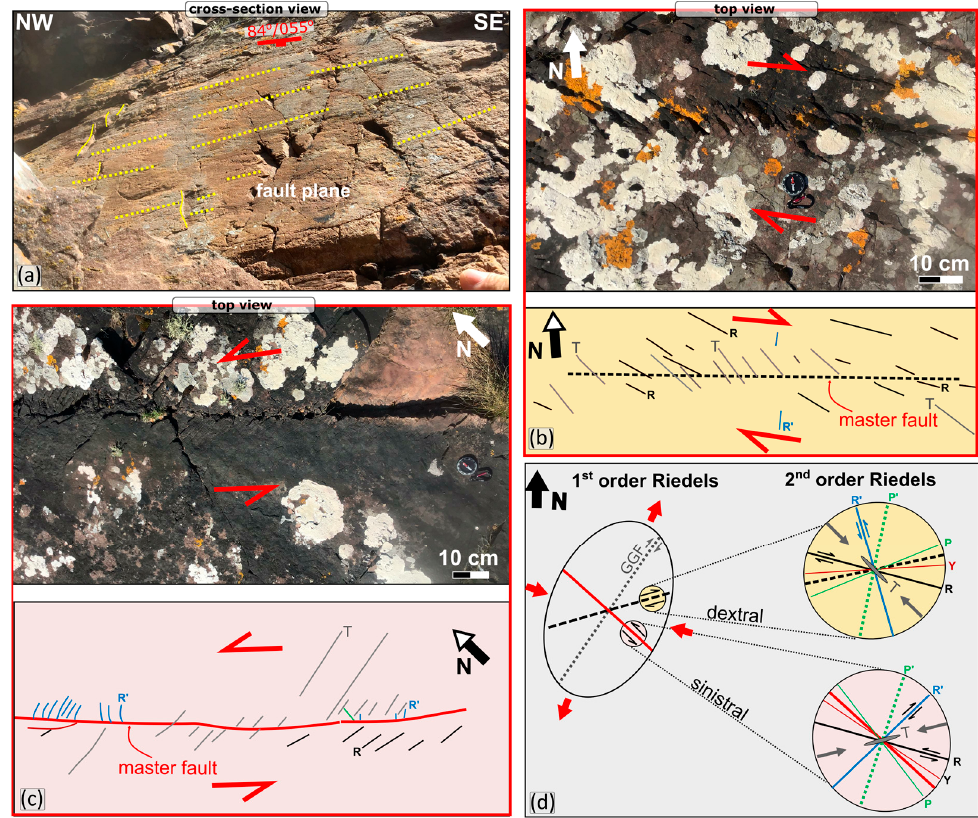
Figure 10. ( a ) Field photographs of an NW–SE-trending fault plane showing sub-horizontal slickenline lineations (pitch 10°NW) suggesting strike-slip kinematics. ( b ) Field photograph and interpreted fracture network of a small-scale dextral fault. ( c ) Field photograph and interpreted fracture network of a small-scale sinistral fault. ( d ) Strain ellipse showing the predicted fault orientation and associated second-order structures matching the two Riedel shear sets in ( b ) and ( c ). GGF = Great Glen Fault.